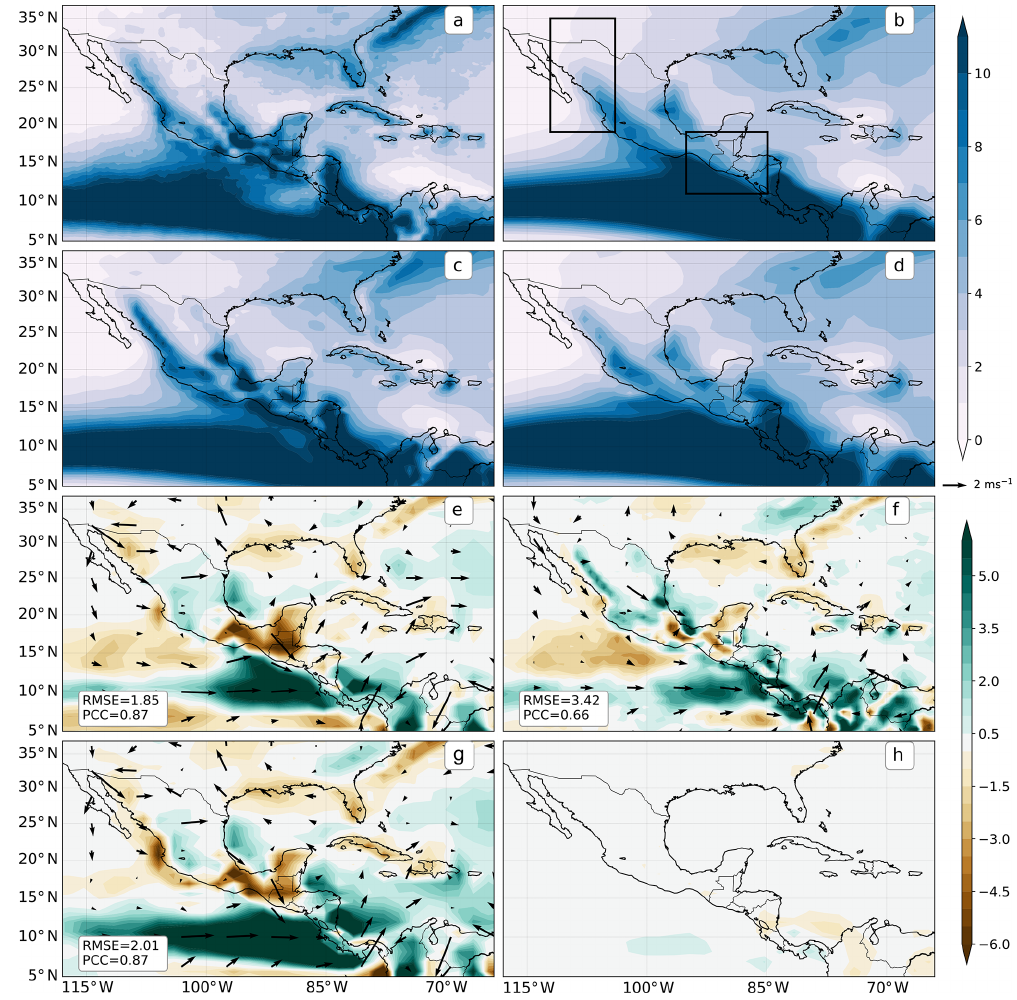
Figure 7. As in Fig. 6 but for JJA in the northern part of subtropical